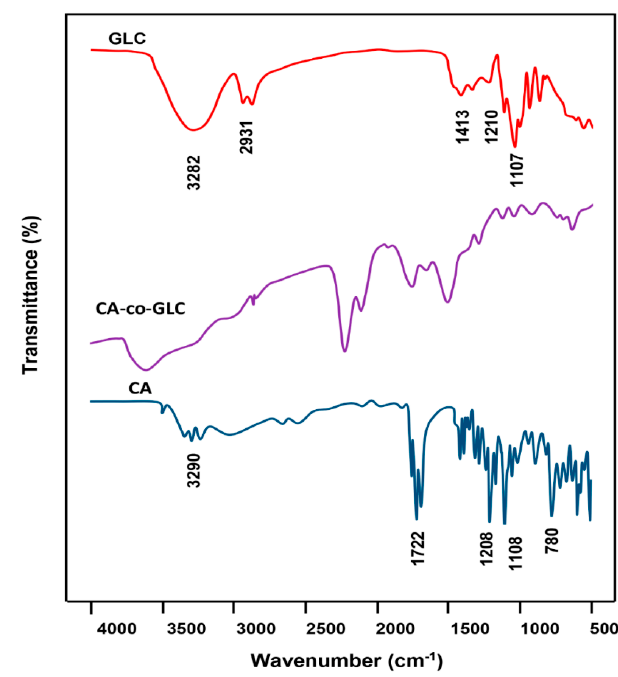
Figure 1. FT-IR spectra of the CA and GLC monomers and CA-co-GLC copolymer.